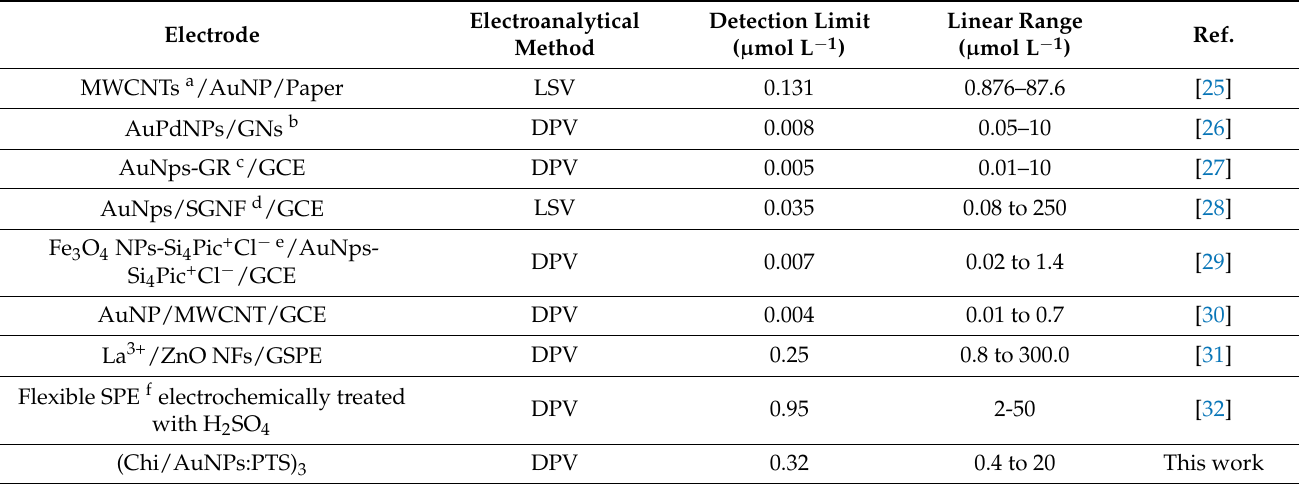
Table 1. Comparison of the analytical performance of the proposed sensor with other AuNPs- modified electrode sensors for BPA